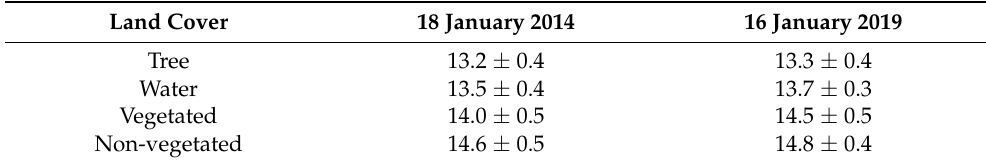
Table 4. Mean surface temperatures and their standard deviations (in degree Celsius) for aggregated land cover classes.